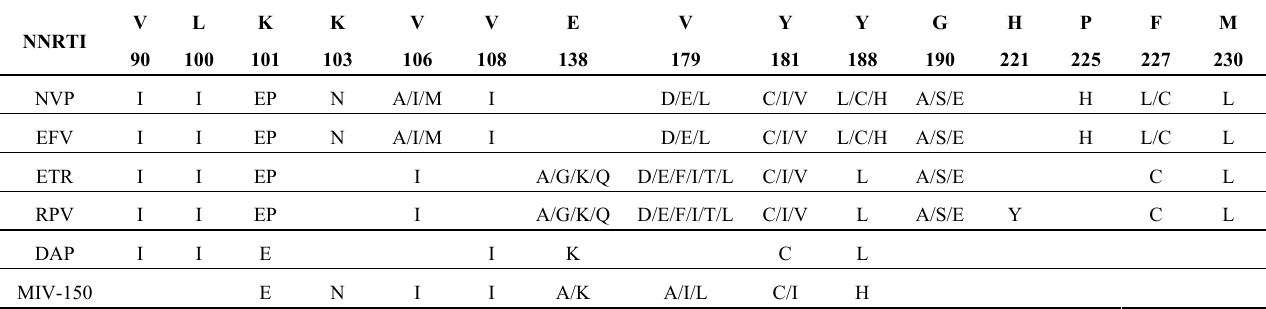
Table 1. Mutations associated with the NNRTIs discussed in this